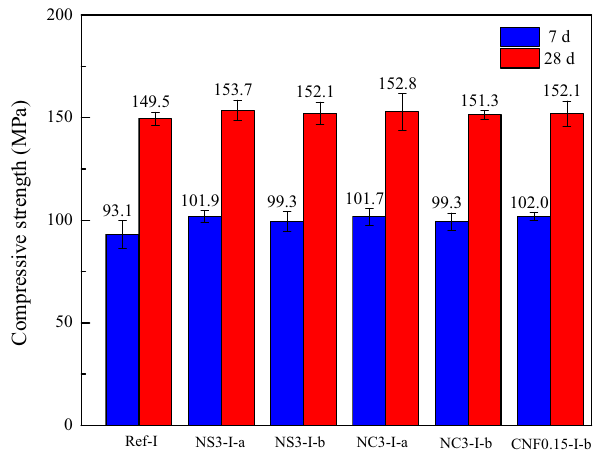
Figure 9: E ff ects of nanomaterials and mixing methods on the compressive strength of